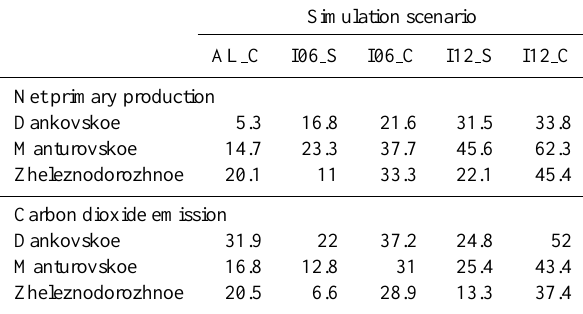
Table 3. Relative increases (%) of NPP and CO 2 emission (MgCha − 1 ) at different levels of deposition of nitrogen com- I12 – increase of 12kgNha − 1 yr − 1 ) and climatic scenarios ( S – ambient climate, C – climate change) for different climatic zones, in comparison to ambient level and ambient climate (AL